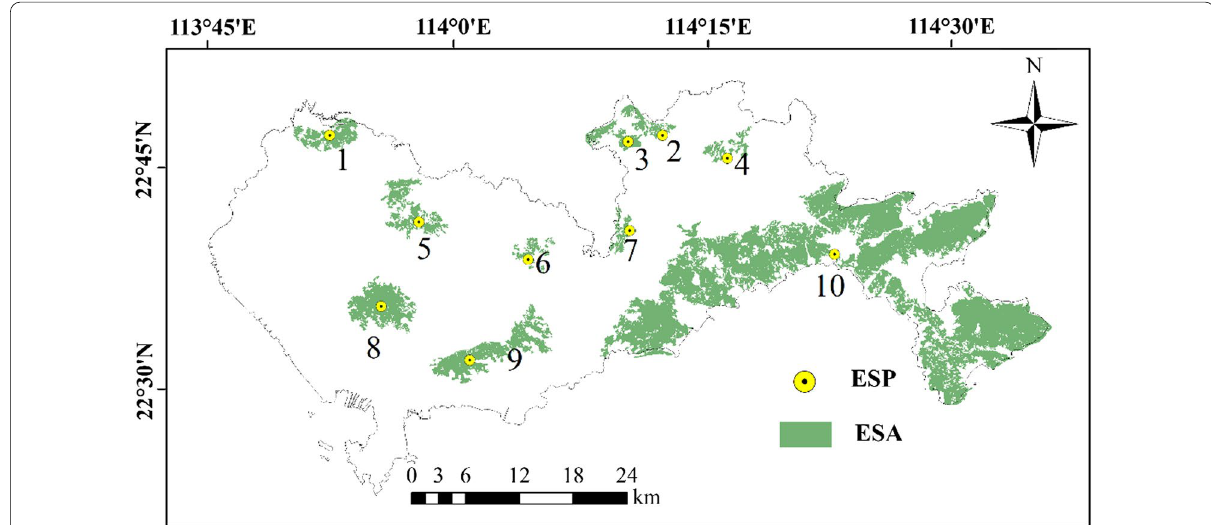
Fig. 4 Distribution of ecological sources in Shenzhen. Numbers from one to ten mark the locations of the ten ecological sources. ESP ecological source point, ESA ecological source area